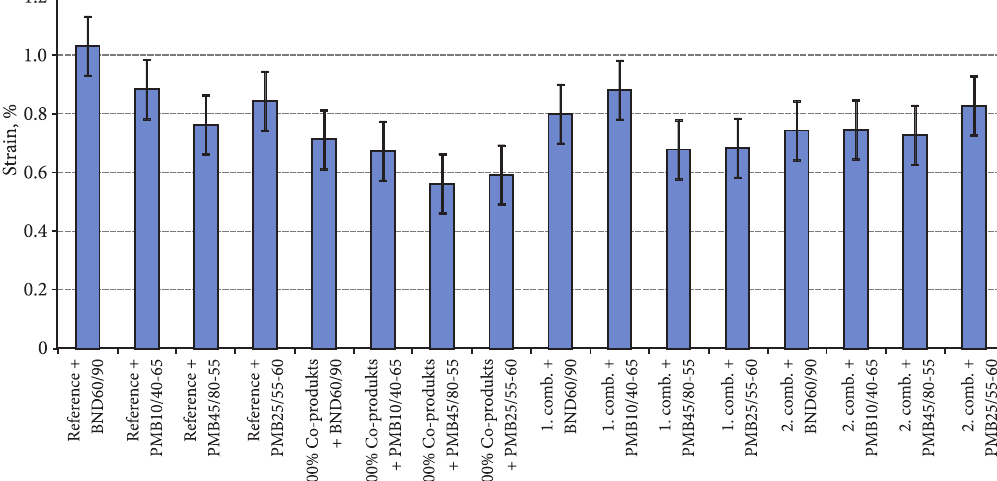
fig. 3. Uniaxial compression test results